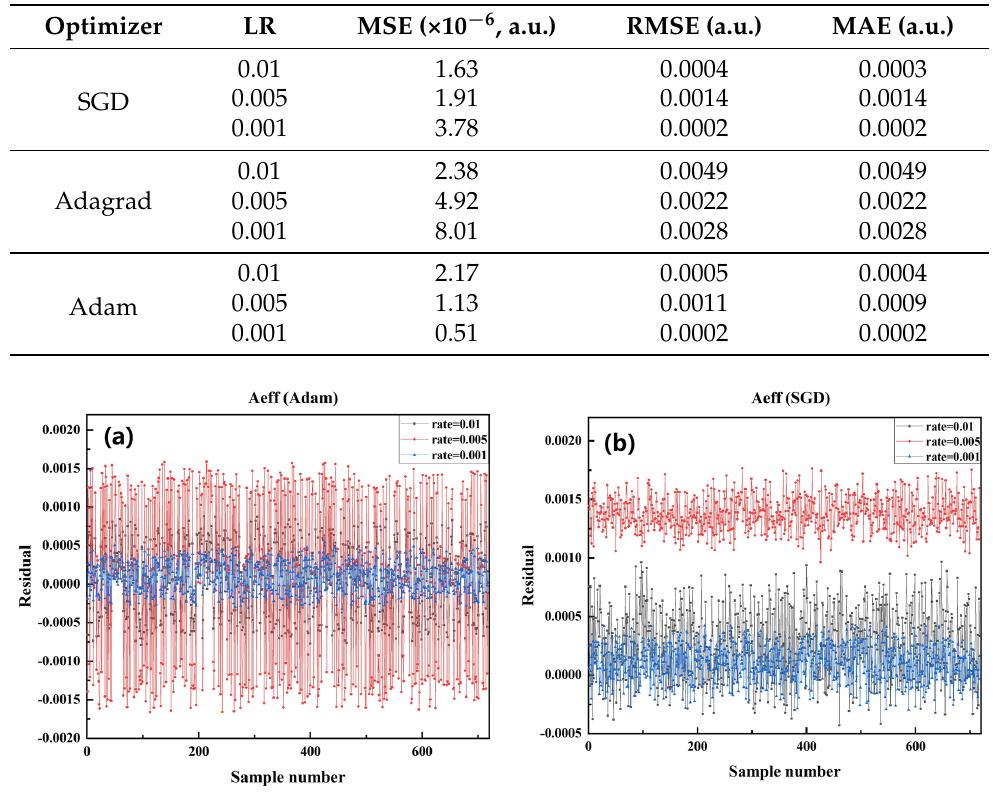
Figure 3. Comparison of the residual between the predicted value and the actual value of A ef f in the test data set of the model trained by each algorithm under different learning rates in SGD optimizer and Adam optimizer. ( a ) Adam optimizer, LR: 0.01, 0.001, 0.005 ( b ) SGD optimizer, LR: 0.01, 0.001,